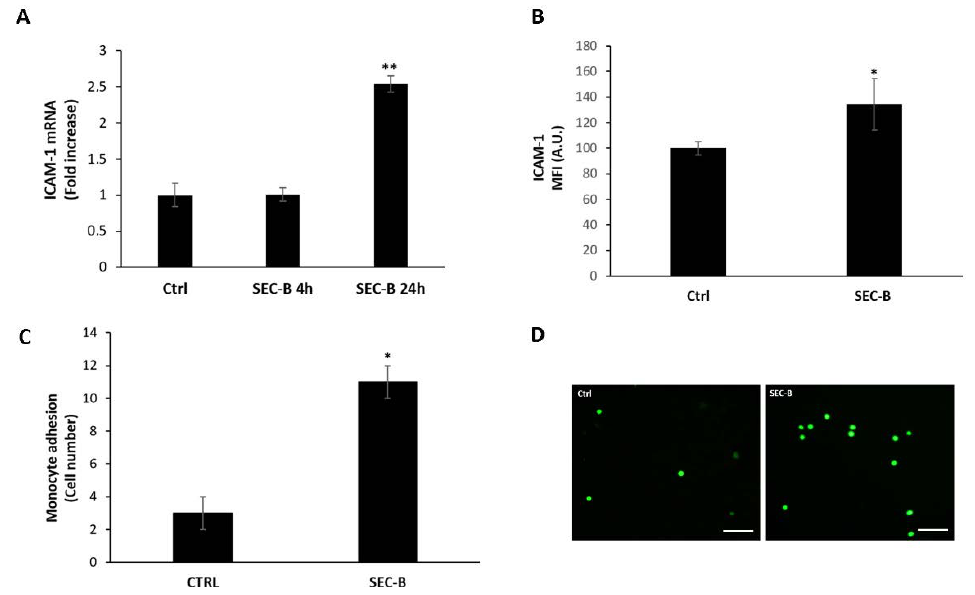
Figure 5. SEC-B upregulates ICAM-1 expression and promotes adhesion of U937 cells. ( A ) Real-time PCR analysis of ICAM-1 mRNA expression after 4 h and 24 h of SEC-B treatment. ( B ) Evaluation of ICAM-1 surface expression at 24 h of SEC-B treatment by flow cytometry. ( C ) Quantification of the number of bound U937 cells in six randomly selected images with 10× magnification. ( D ) Representative fluorescence images showing the effects of SEC-B on adhesion of calcein-AM-labeled U937 cells to HMEC-1 treated for 24 h. Scale bar: 200 µm. Data are expressed as mean ± SD ( n = 3). * p < 0.05; ** p < 0.01 vs. untreated cells.